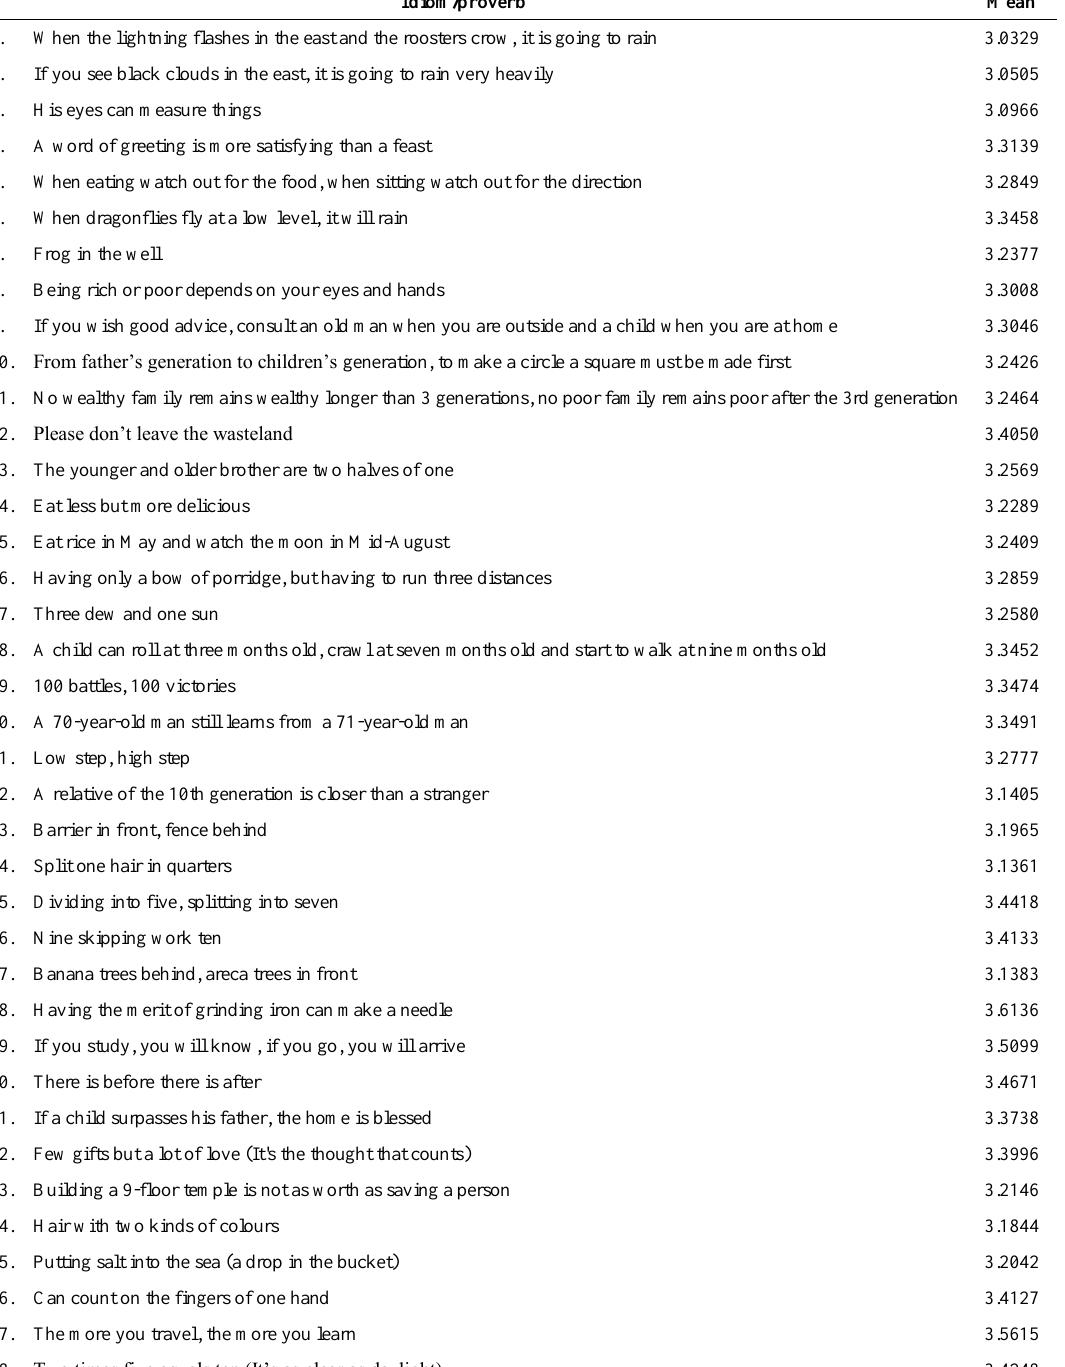
Table 2. The effectiveness of using idioms and proverbs in teaching